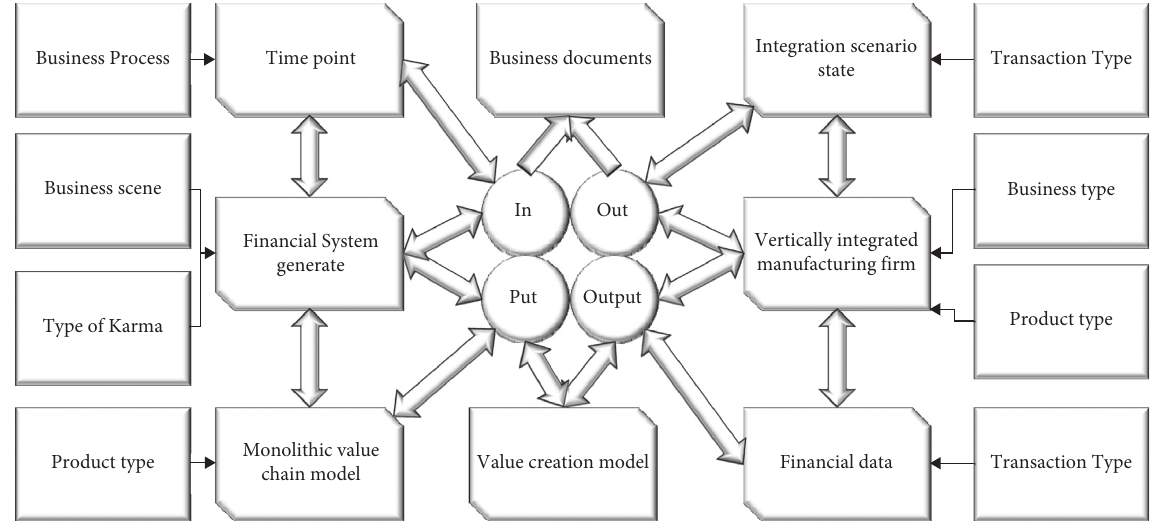
Figure 2: Overall framework of an integrated